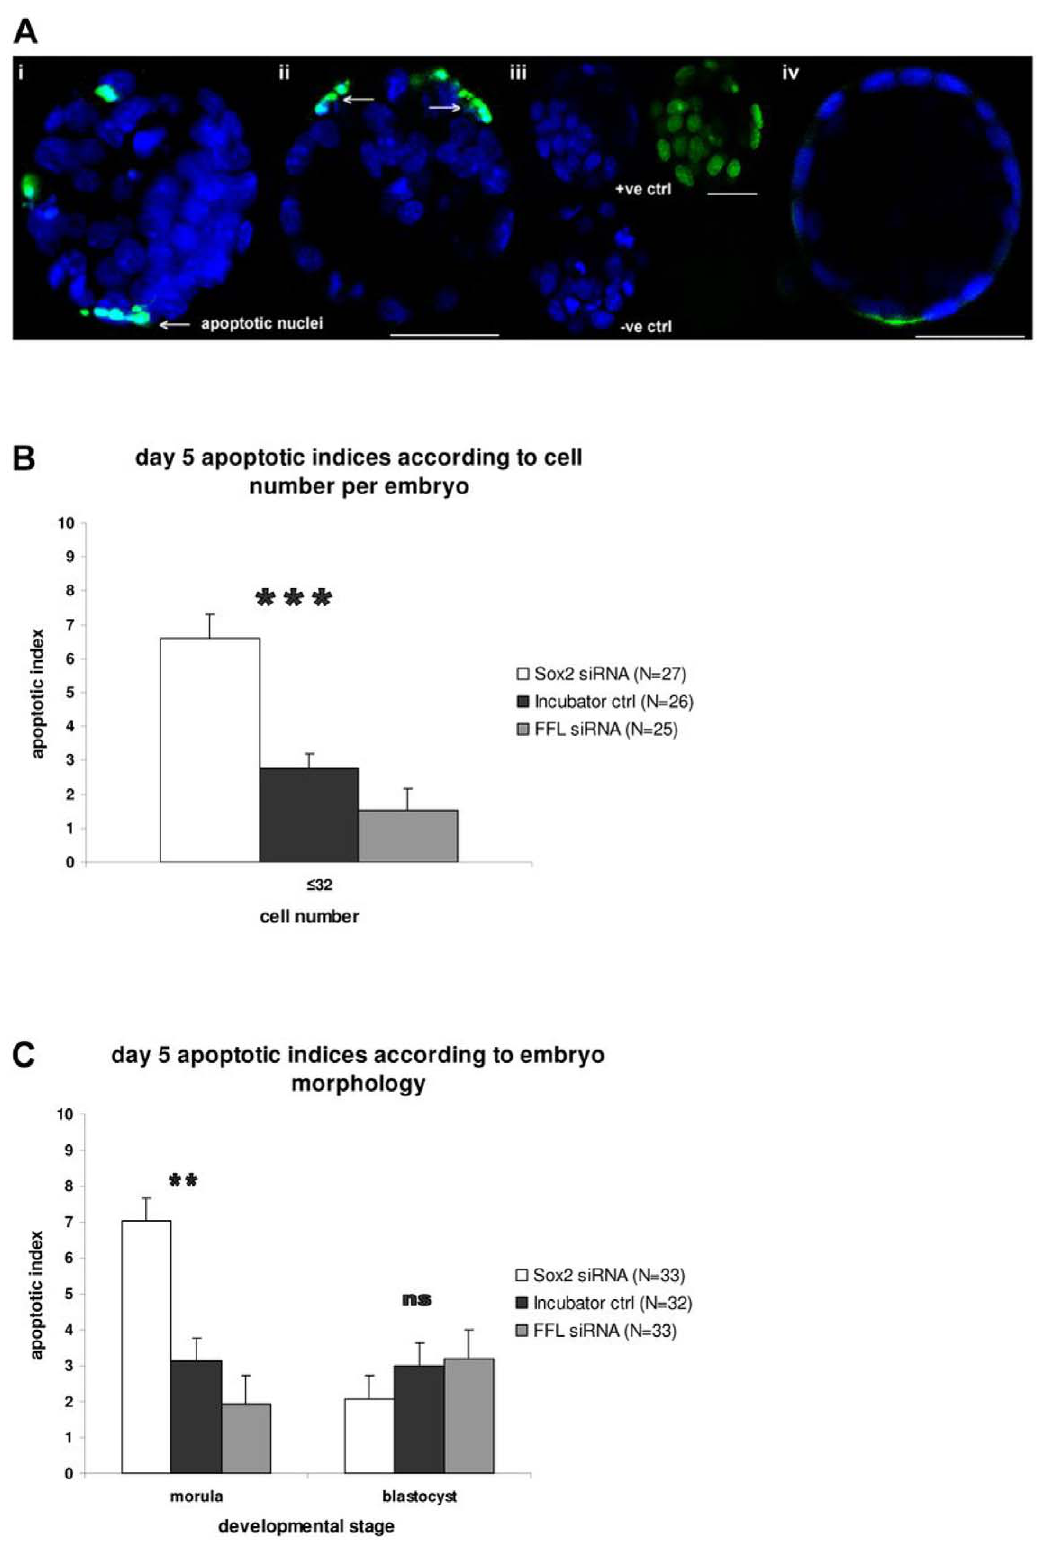
Figure 5. Assessment of apoptosis in embryos using the TUNEL assay. ( A ) Fluorescence analysis for apoptotic cells; the images are single optical sections from confocal Z-series. The fragmented nuclei (green fluorescence) are apoptotic (white arrows). i. Day 5 incubator-control embryo; ii. Day 5 Sox2 knock-down embryo; iii. Controls for the TUNEL reaction (positive control top; negative control bottom; blue DAPI); iv. Day 5 FFL -siRNA embryo. Bars: 50 m m. ( B ) Mean apoptotic indices in embryos with # 32 cells on day 5. Sox2- siRNA embryos (white, N=27) were compared with incubator-control embryos (black, N=26) and FFL -siRNA embryos (grey, N=25). Independent samples T-test revealed significant difference